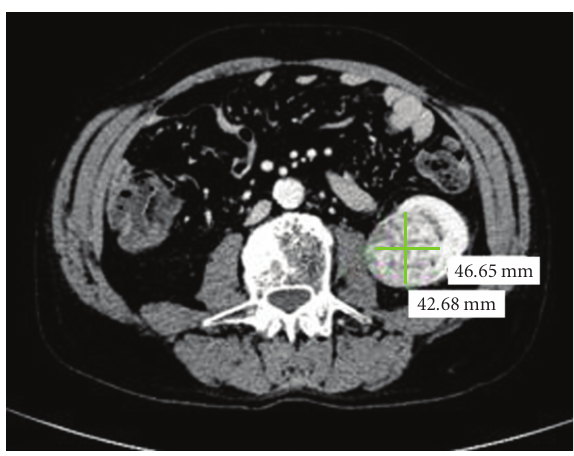
Figure 1: CT scan showing left renal tumor before RIC